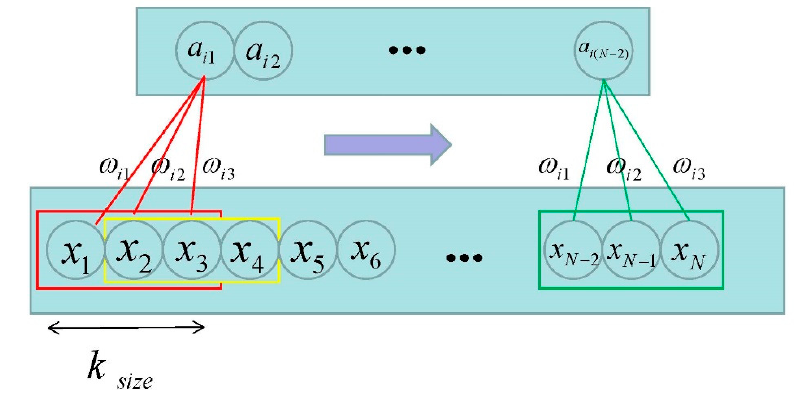
Figure 1. Temporal convolution [28]. (Where N represents the length of the input signal; k size stands for the size of the receptive field; and the three corresponding weights ( w i 1 , w i 2 , w i 3 ) are the i th